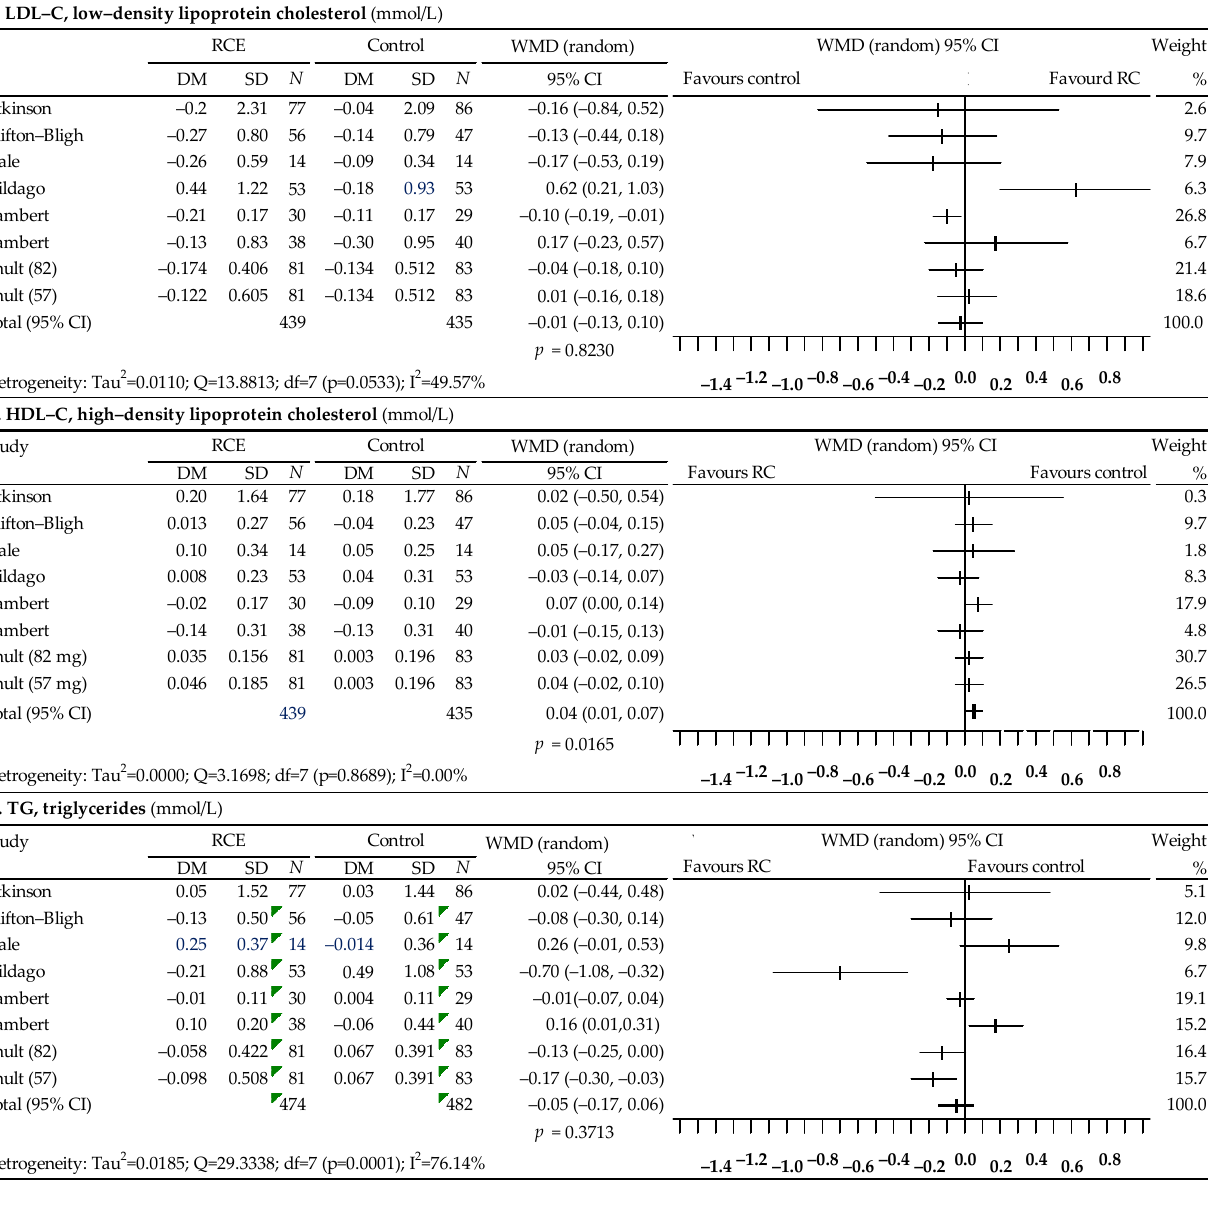
Figure 5. Forest plot representing associations between red clover and lipid profiles. Data are presented as weighted mean difference with 95%